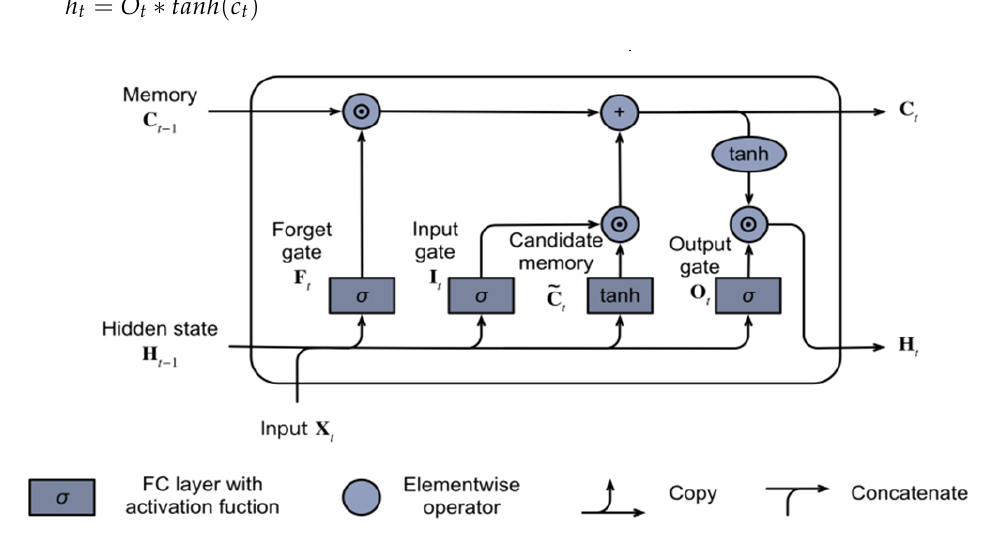
Figure 5. The memory cell of the LSTM